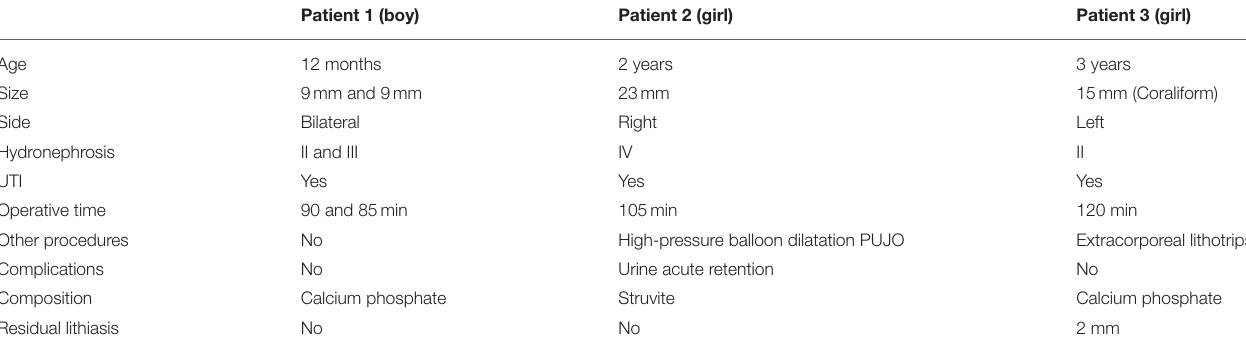
TABLE 1 | Patients